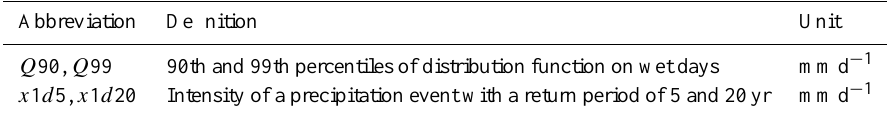
Table 3. Precipitation